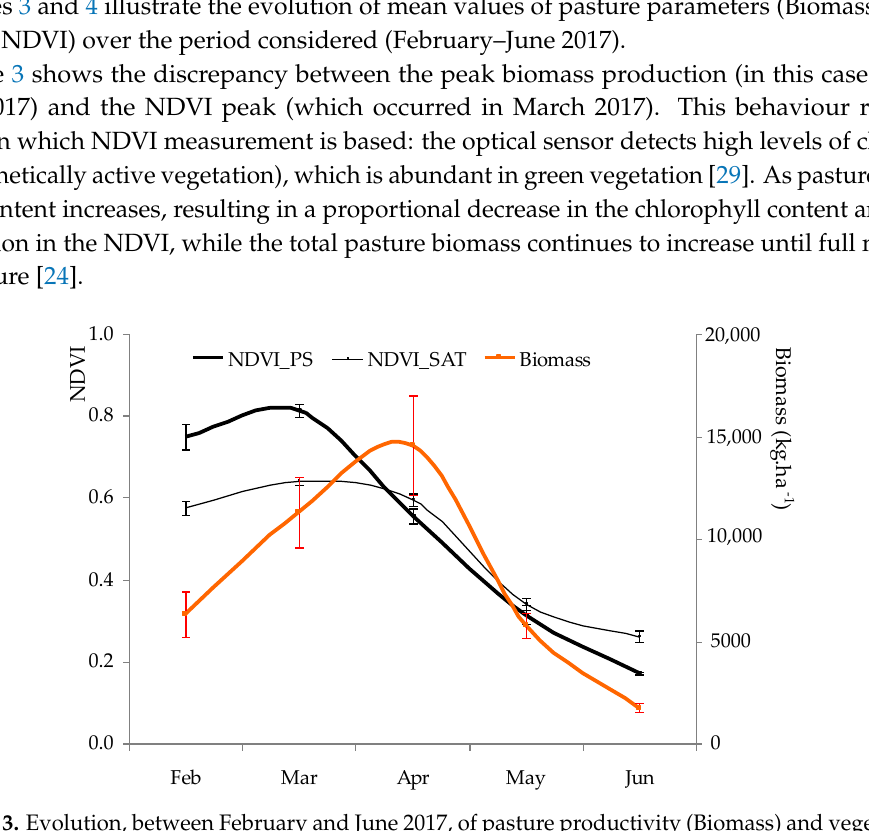
Figure 3. Evolution, between February and June 2017, of pasture productivity (Biomass) and vegetation index obtained by proximal sensor (NDVI PS ) and by satellite (NDVI SAT ). Data are average values of the twelve sampling points.